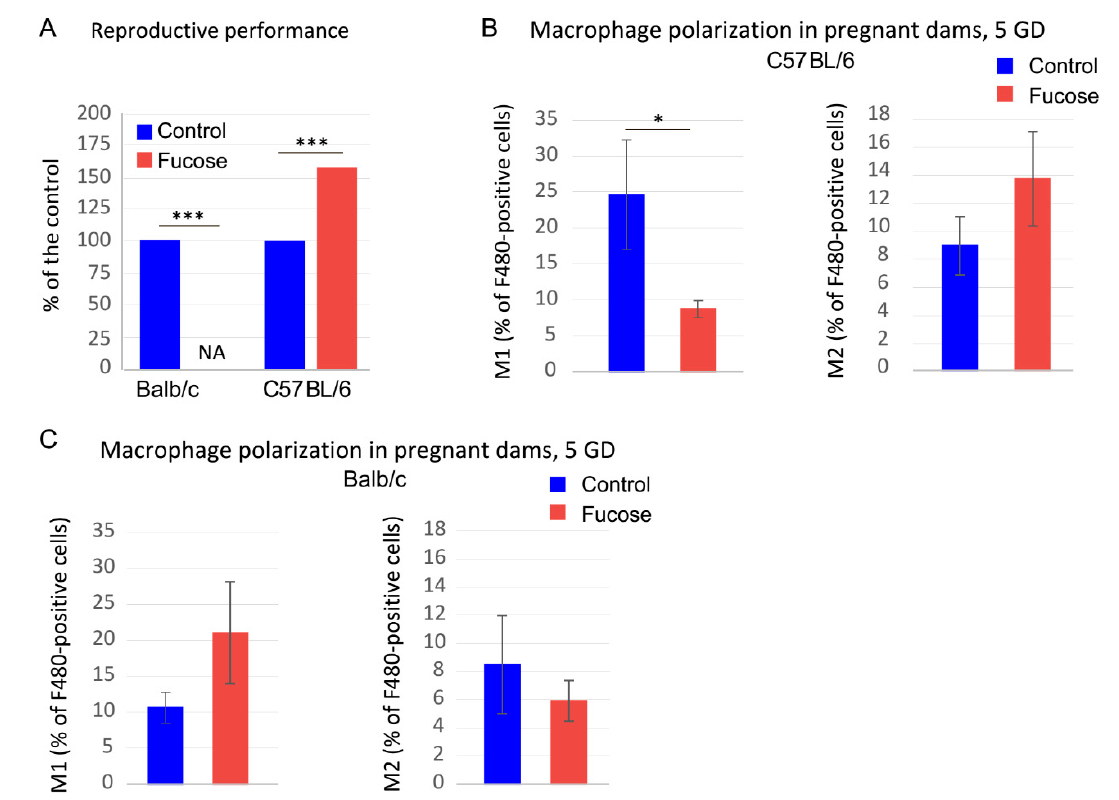
Figure 4. Fucose affects reproductive performance and macrophage polarization in C57BL/6 and BALB/c dams. ( A ). Re- productive performance in C57BL/6 and BALB/c dams upon fucose treatment. *** p < 0.001, Fisher exact test; N(dams) = 9 in each group. ( B ). Percentage of M1 and M2 macrophages upon fucose treatment in pregnant C57BL/6 dams. “Fucose” vs. “Control”: * p < 0.05, N = 3–4, Mann–Whitney U test. ( C ). Percentage of M1 and M2 macrophages upon fucose treatment in pregnant BALB/c dams, N = 3–8.